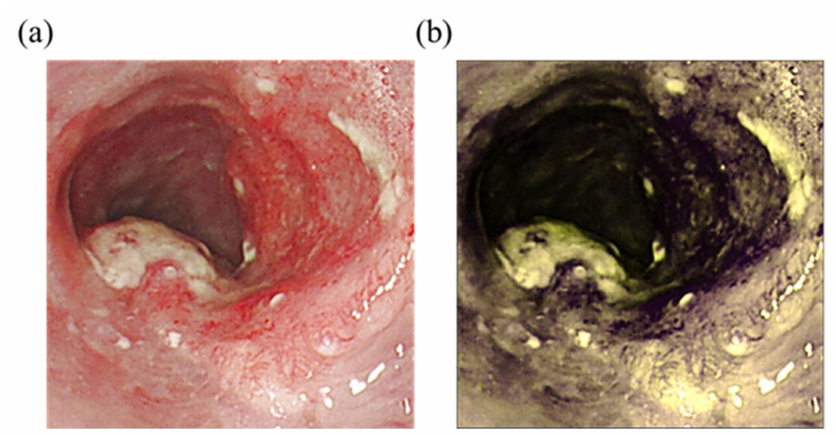
Figure 2. Comparison of WLIs and HSI images. ( a ) Original WLI; ( b ) HSI image of the NBI. Single-shot multi-box detector (SSD) is a single-shot multi-category target